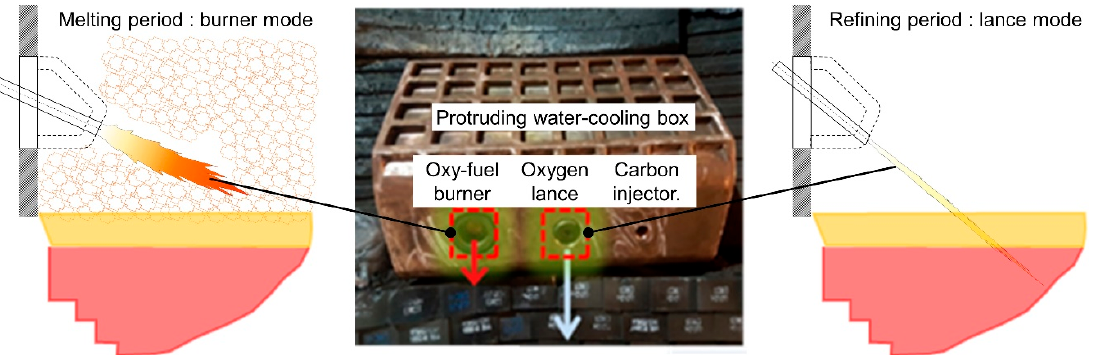
Figure 6. Developed protruding water-cooled jacket installed at the EAF wall with different operating modes.